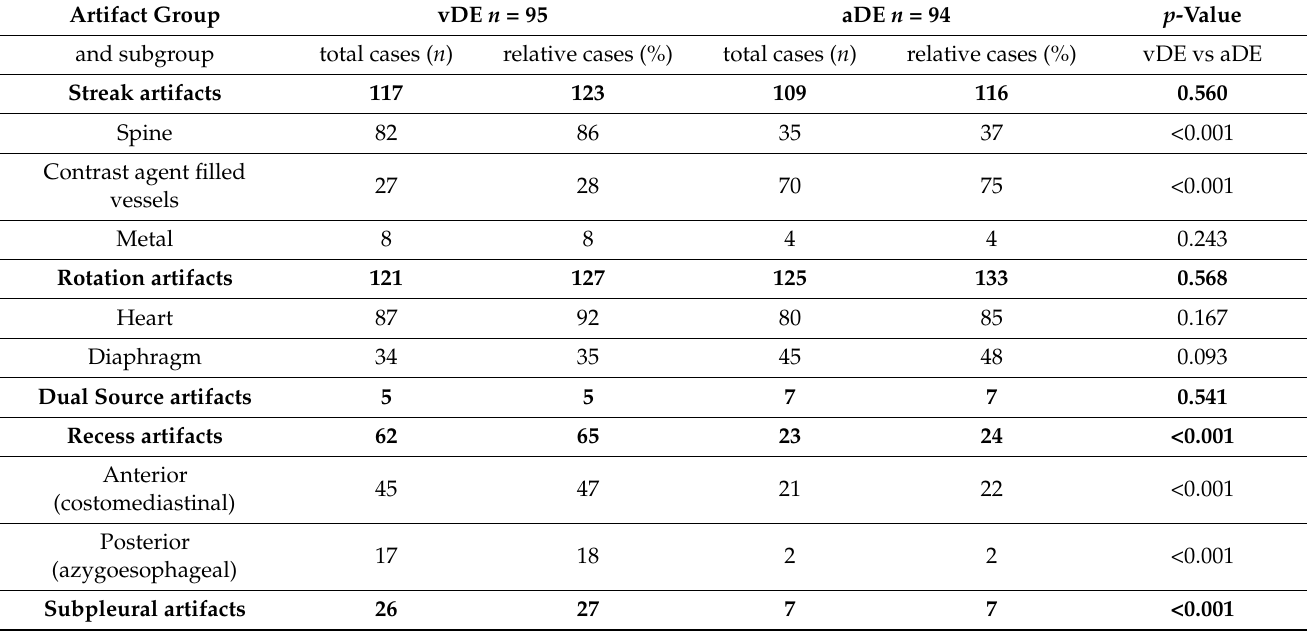
Table 3. Image artifacts in the perfusion blood volume (PBV) images: Nine different types of artifacts were found repeatedly and were classified into five groups based on their origin. Results are displayed as total number ( n ) and percentage (%) in the study (vDE—portal-venous thoraco-abdominal Dual Energy CT) or reference group (aDE—pulmonary arterial Dual Energy